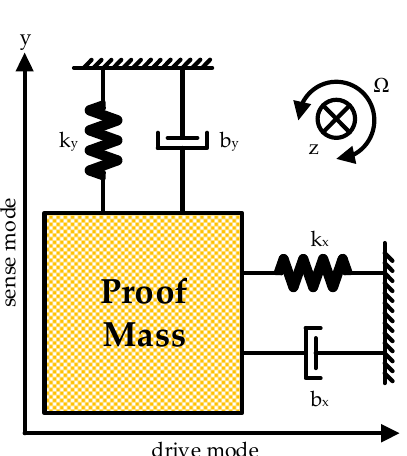
Figure 1. Mechanical vibration model for MEMS gyroscopes.